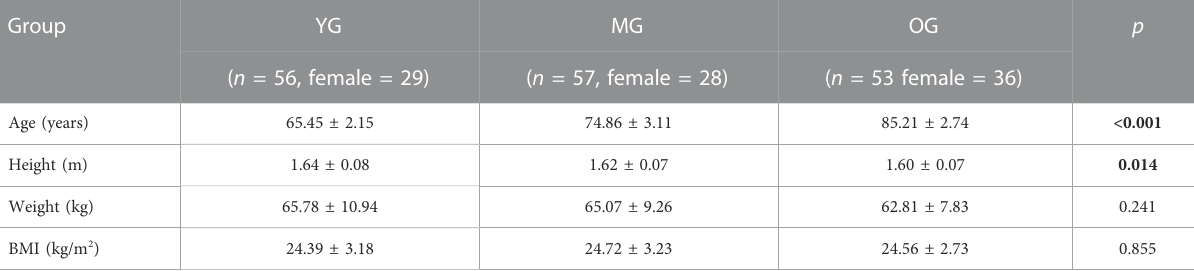
TABLE 1 Participants ’ information. Group